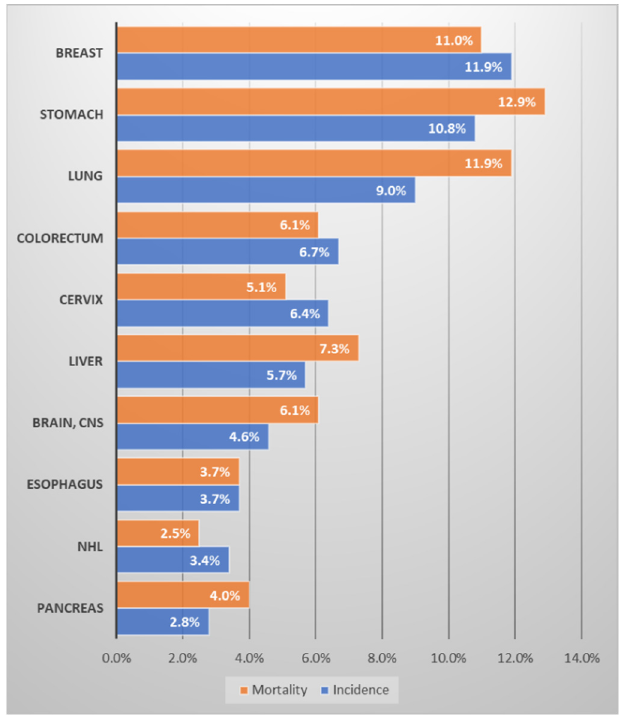
Figure 2. Ranking of the frequency and mortality of major cancers in Uzbekistan. Data source: Cancer country profile, WHO, 2020; Global Health Observatory, WHO, 2016. Figure drawn by authors [10,14].